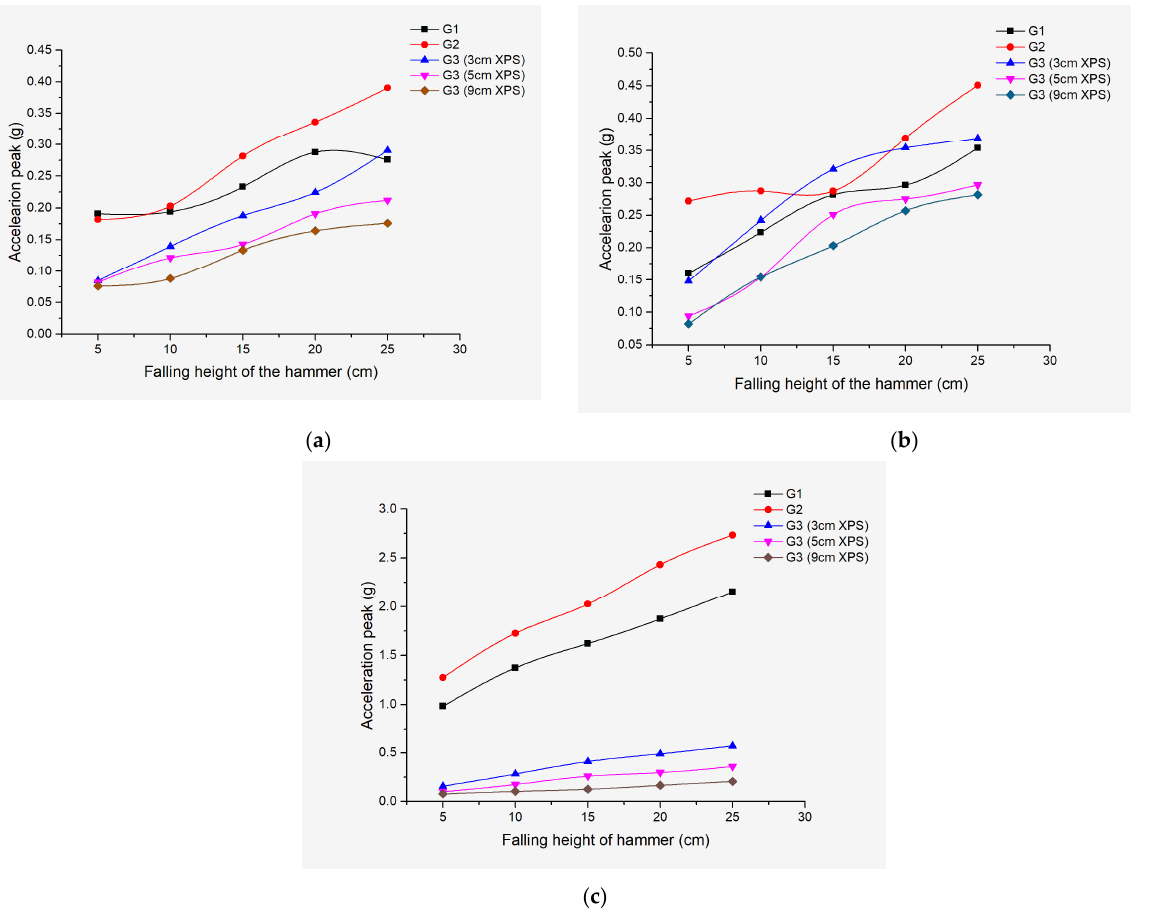
Figure 5. Acceleration peak values of the three test groups. ( a ) Acceleration peak in the X-direction; ( b ) Acceleration peak in the Y-direction; ( c ) Acceleration peak in the Z-direction. Acceleration peak in the Y-direction; ( c ) Acceleration peak in the